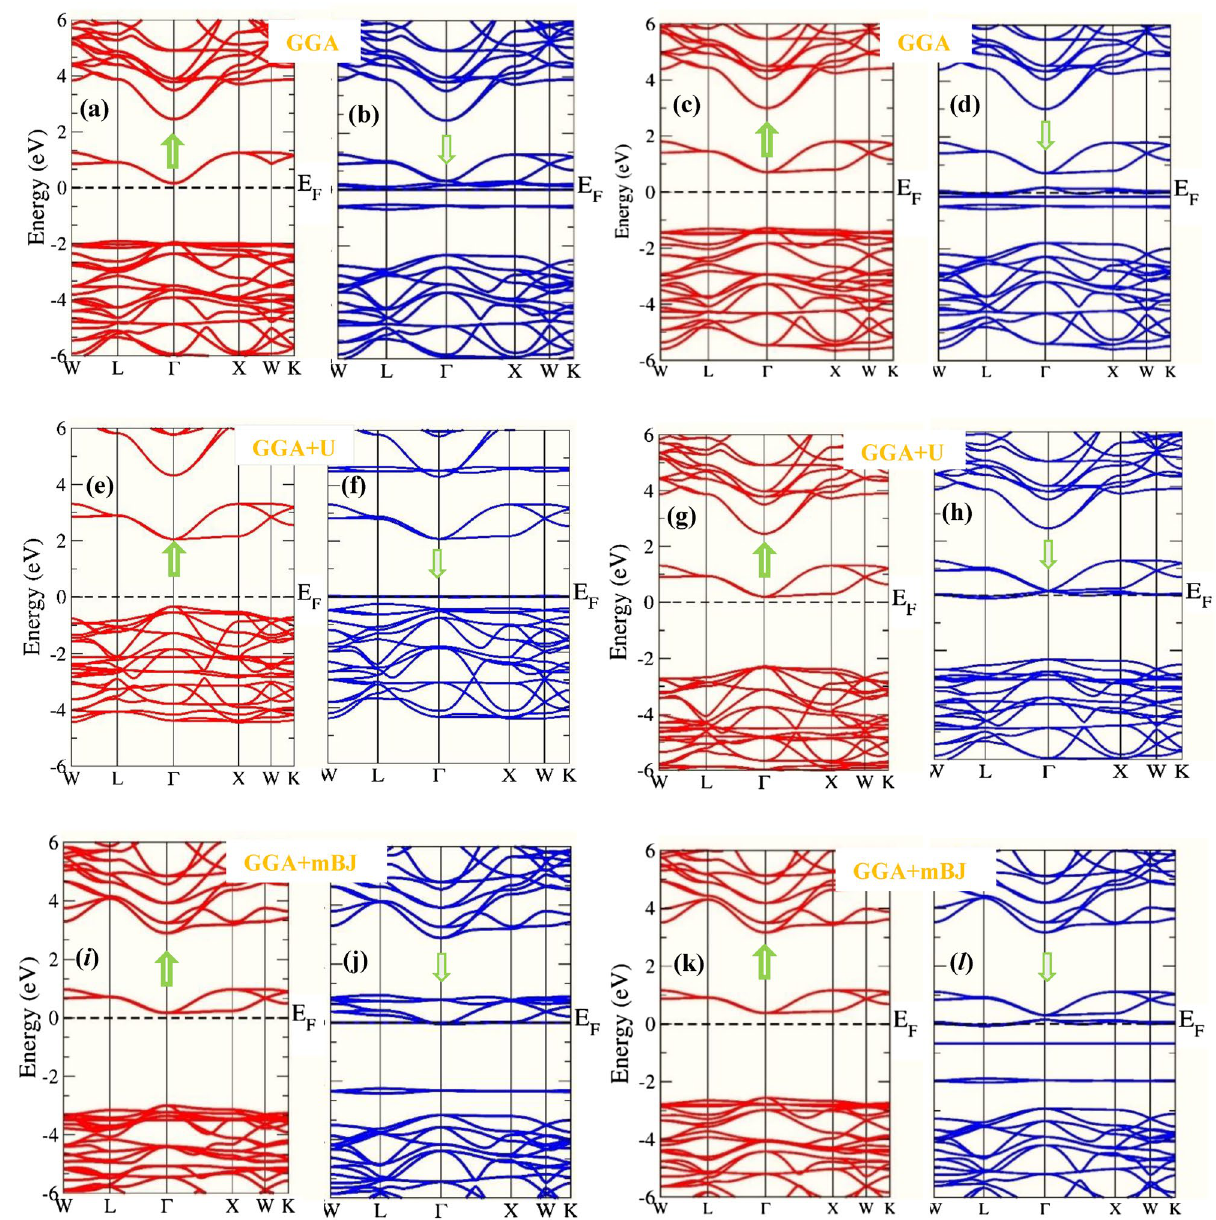
Figure 4. ( a – d ) DFT execution of band profiles of Ba 2 ErNbO 6 and Ba 2 TmNbO 6 wthin GGA where the arrows represents the possible spin-up and spin-dn orientations. ( e – h ) DFT execution of band profiles of Ba 2 ErNbO 6 and Ba 2 TmNbO 6 wthin GGA + U where the arrows represents the possible spin-up and spin-dn orientations. ( i – l ) DFT execution of band profiles of Ba 2 ErNbO 6 and Ba 2 TmNbO 6 wthin GGA + mBJ where the arrows represents the possible spin-up and spin-dn